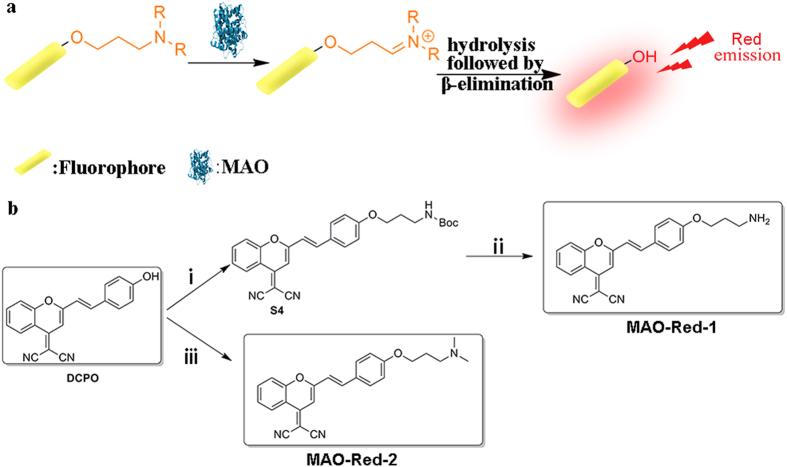
(a) The oxidative deamination mechanism of MAO. (b) Synthetic route to MAO reporters: MAO-Red-1 and MAO-Red-2. Reagents and conditions: (i) K2CO3/DMF, r.t, 83%; (ii) HCl/MeOH, r.t, 98%; (iii) K2CO3/CH3COCH3, reflux, 61%.